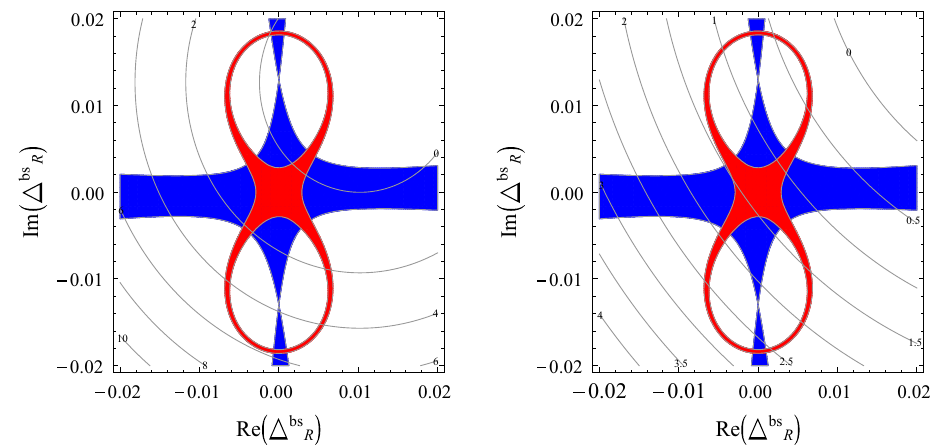
π 0 η (cid:3) ( R ρ 0 η (cid:3) ) in the RHS. The shaded red ( blue ) region is allowed from the bounds on (cid:5) M 2 2